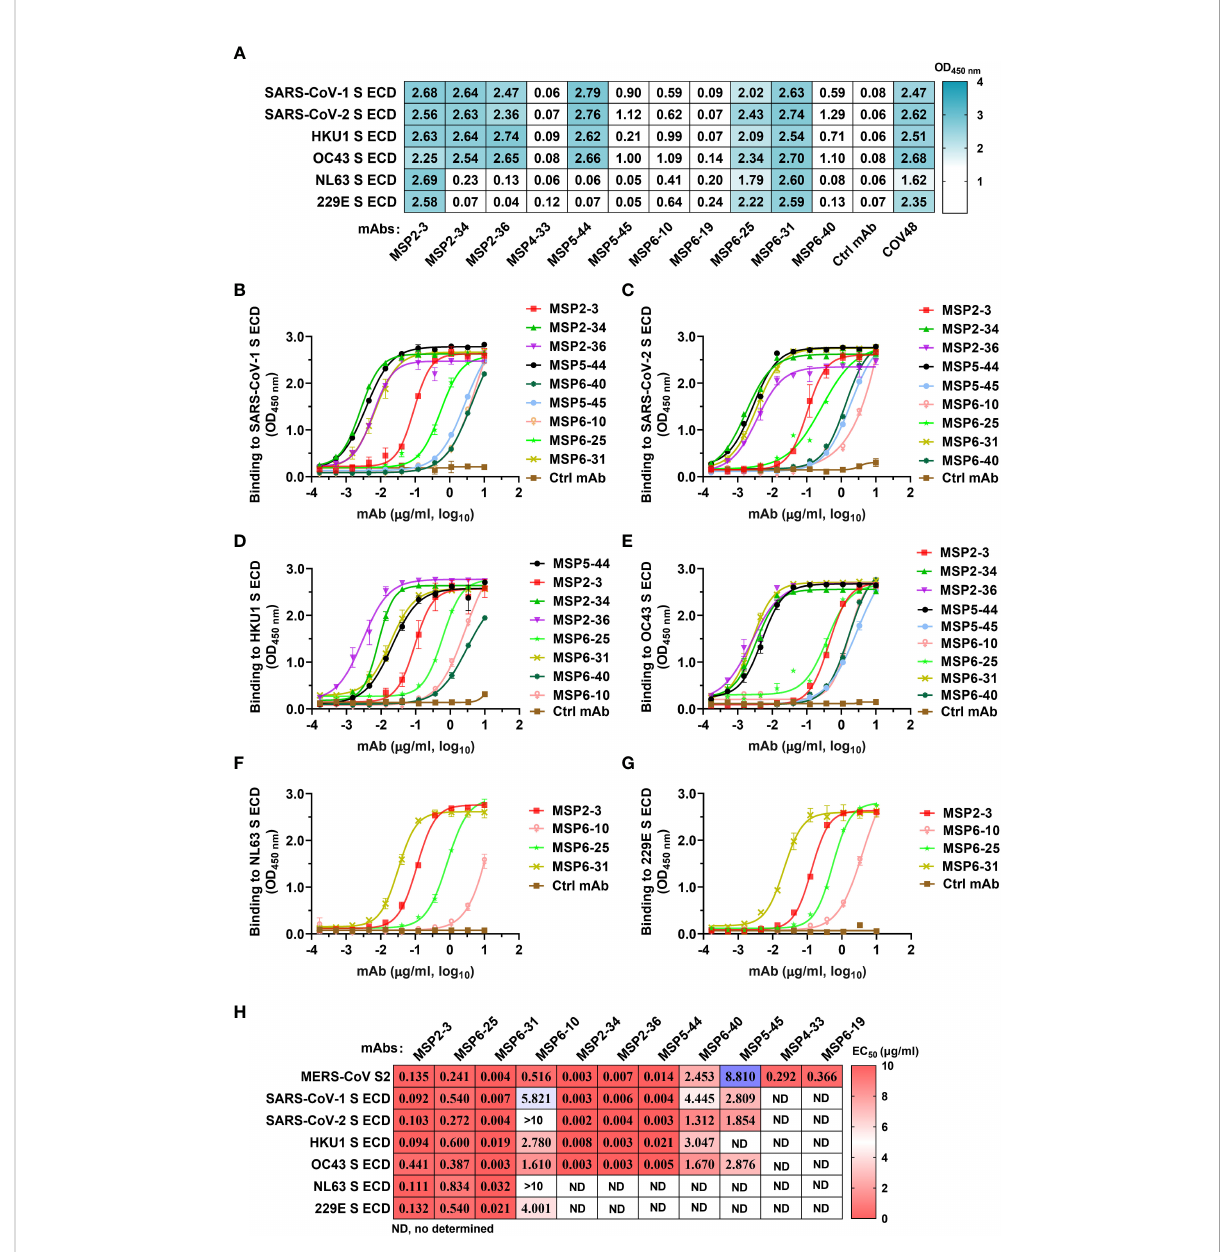
FIGURE 3 Cross-reactivity of mAbs isolated from COVID-19 convalescents with other hCoVs. (A) Cross-reactivity of mAbs with seven human coronaviruses (hCoVs) at a concentration of 1 m g/ml. The positive control COVID-19 serum COV48 (1:1000 dilution) and unrelated anti-HCV mAb 2HCV5 (Ctrl mAb) were used as positive and negative controls, respectively. OD 450 nm >0.3 was de fi ned as a positive reaction. (B – G) ELISA binding curves of mAbs reactive to hCoVs S ECD (panel A). The S ECDs of SARS-CoV-1, SARS-CoV-2, HKU1, OC43, NL3, and 229E were coated at 2 m g/ml. An unrelated anti-HCV mAb 2HCV5 (Ctrl mAb) was used as a negative control. Data represent the mean ± SEM of two replicates. (H) The EC 50 of mAbs binding to various spike ECD proteins. Data are calculated from panes (B – G) . ND, no or low reaction in single dose screening (A) , thus it was not determined by dose-dependent ELISA. Data were analyzed and plotted by GraphPad Prism (version